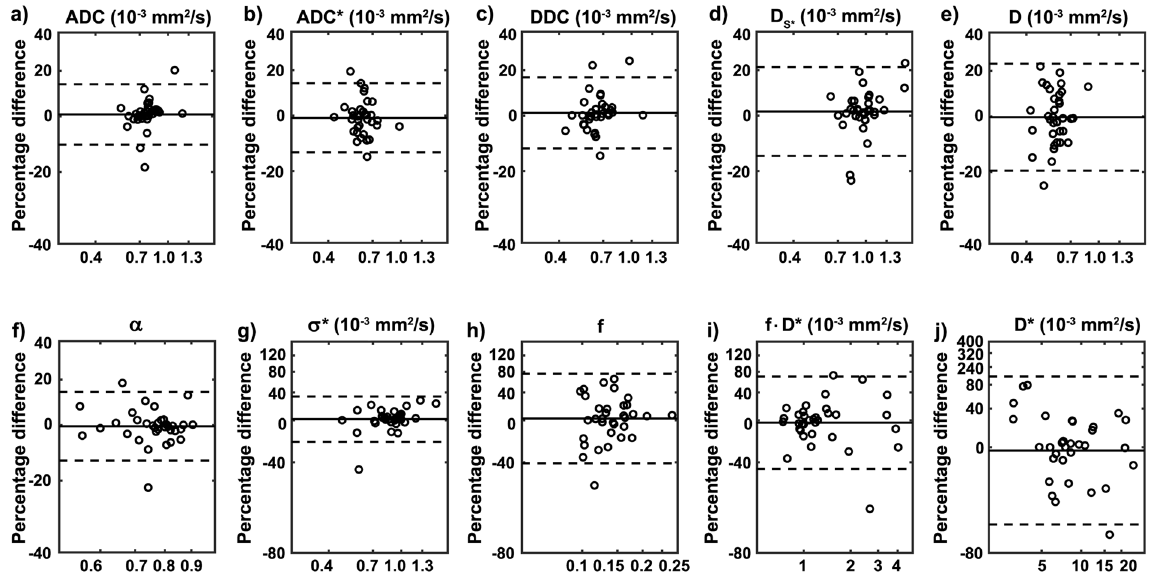
Figure 1. Illustration of measurement repeatability of the various diffusion parameters. Bland-Altman plots on a log-log scale of ( a ) ADC, ( b ) ADC * , ( c ) DDC, ( d ) D s * , ( e ) D and of the diffusion parameters ( f ) α , ( g ) σ * , ( h ) ( f , i ) f·D * , and ( j ) D * . The solid lines correspond to the mean differences between two estimates and the dashed lines show the 95% limits of agreement. To facilitate comparison, the same scales have been used on the y-axes of graphs ( a – f ) and ( g – i